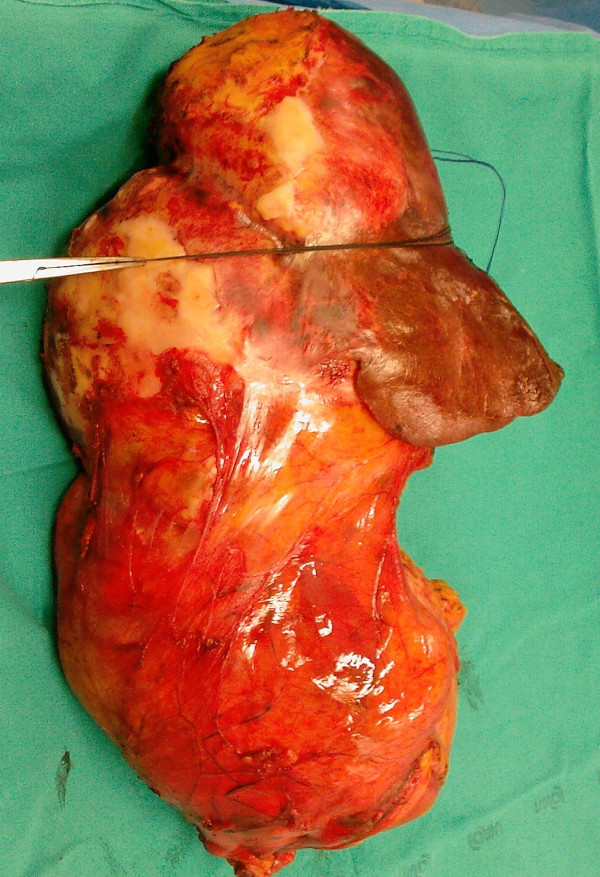
Specimen ofen blocresection of right liver and giant hydatid cyst.